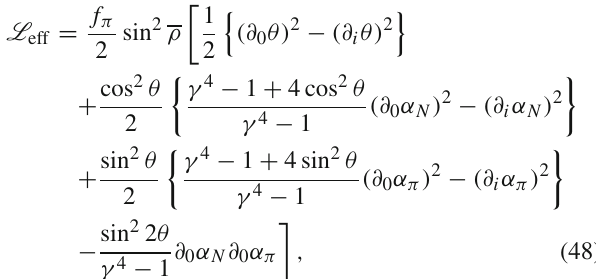
= 1 . 15 and the dotted blue line to I